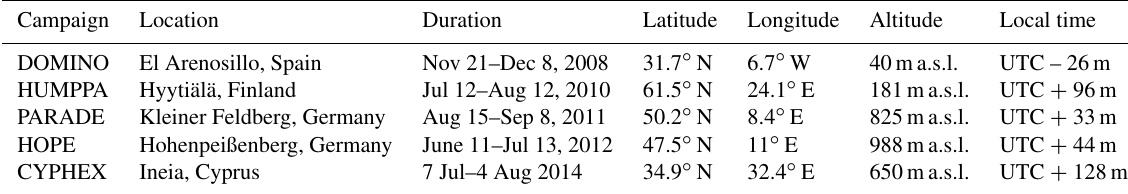
Table 1. Observational sites.